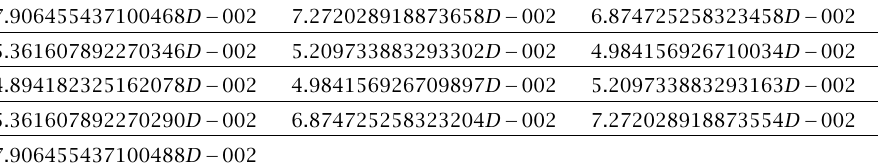
Table 3.4 . The errors with n = 13 , l = 0 . 75 on γ 0